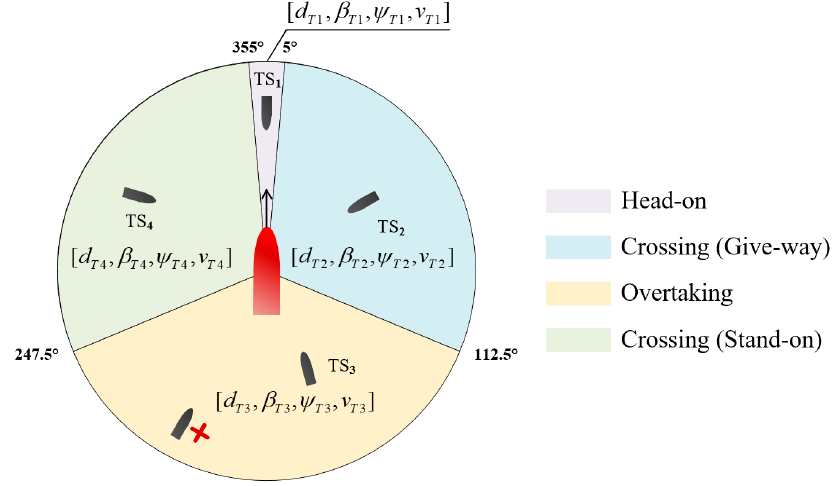
Figure 3. Target ship classification and its state space determination on the basis of the COLREGs.